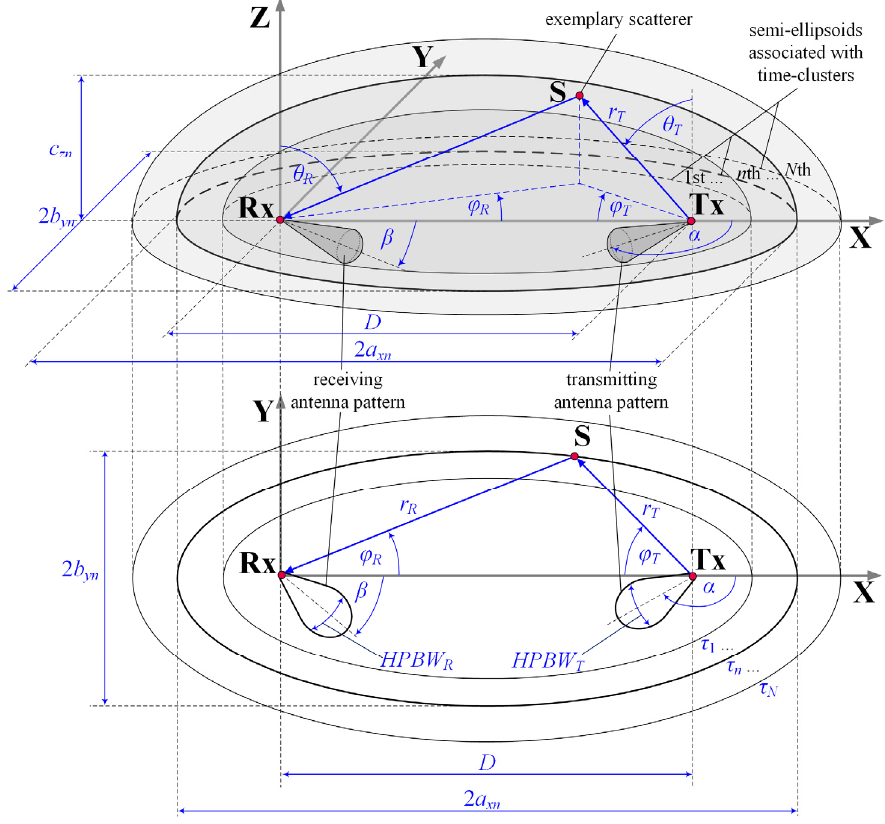
Figure 1. Scattering geometry of MPM.